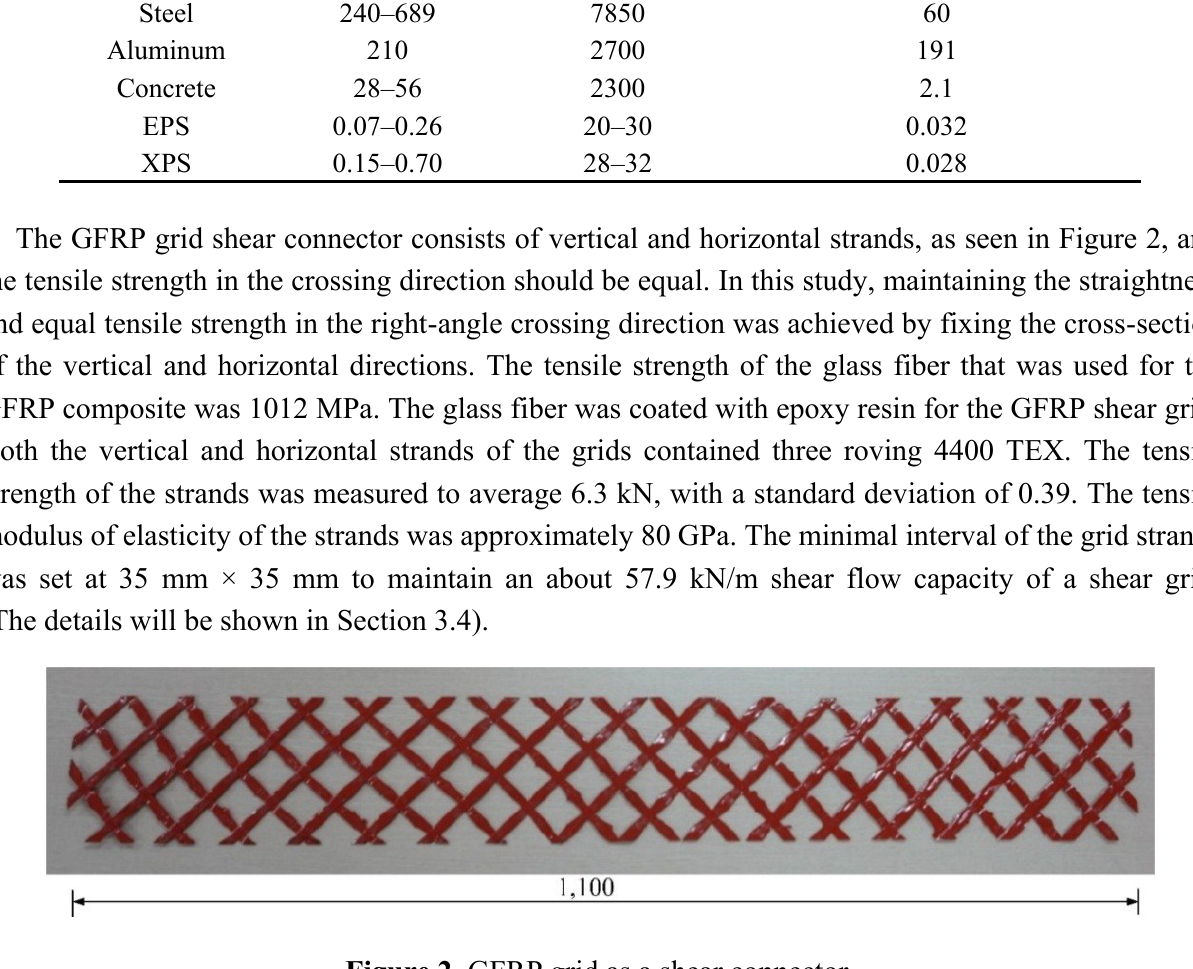
Figure 2. GFRP grid as a shear